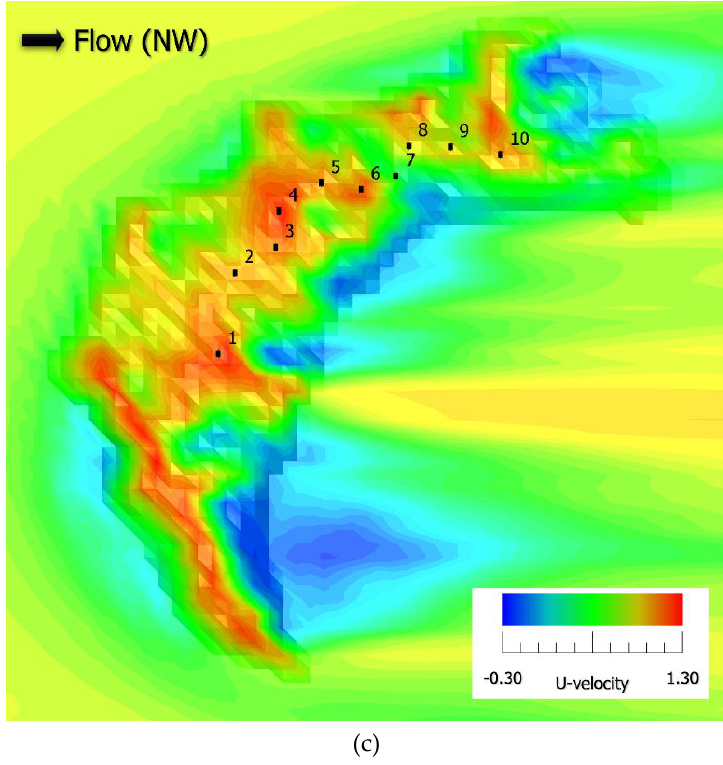
Figure A3. Comparison of the spatial distribution of time-averaged U-velocity at a wind turbine hub height of 30 m for north-westerly wind—( a ) 5 m, ( b ) 25 m, and ( c ) 50 m.